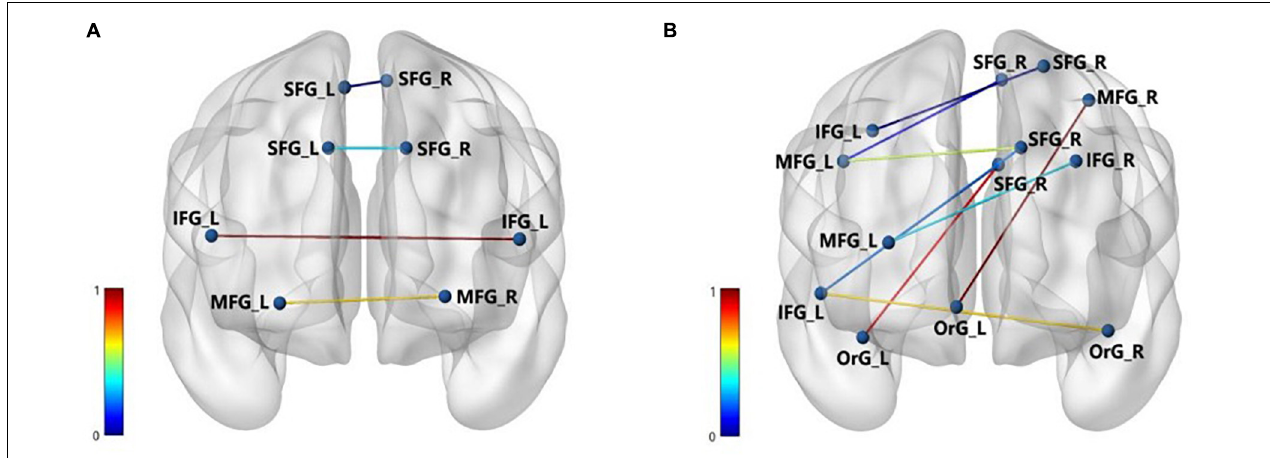
FIGURE 4 | The important brain connections of Ho (A) and He (B) . The nodes represent the corresponding brain area, and the edges are the important connection between the areas. The normalized values of the edges indicate the importance of brain